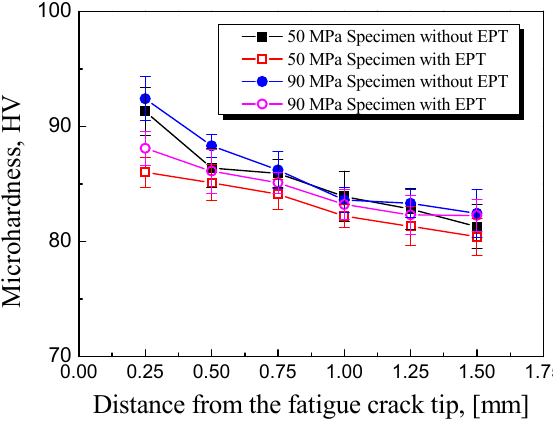
Figure 5. Results of Vickers microhardness (HV) measurements for specimens with and without EPT.